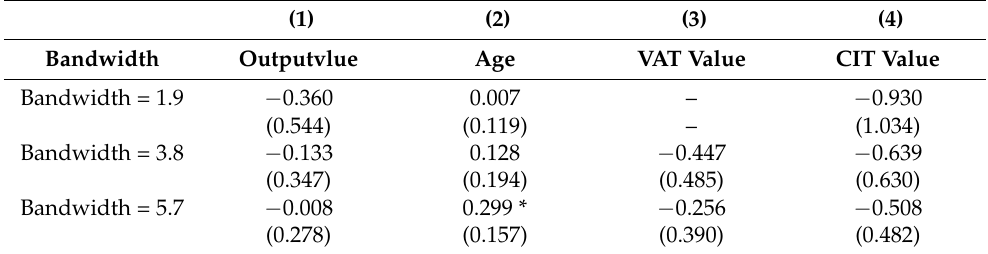
Table 4. Identification checks: impact of the tax collection reform on covariates.